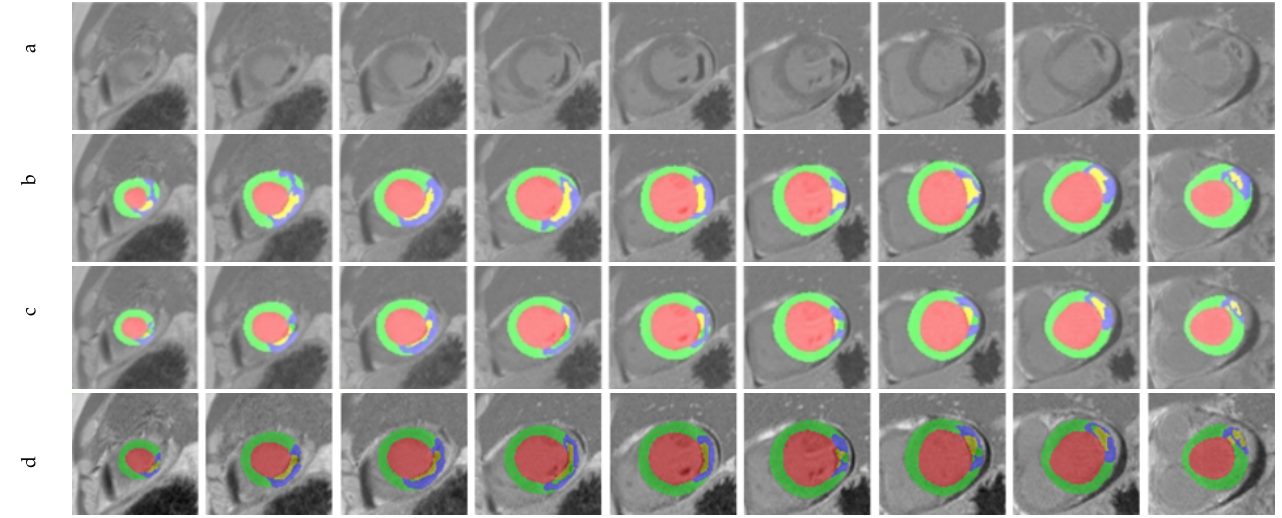
Figure 6. Segmentation results and the ground truth mask on Case 119. ( a ) LGE-MRI, ( b ) Ground Truth, ( c ), Zhang [47], and ( d ) ICPIU-Net.